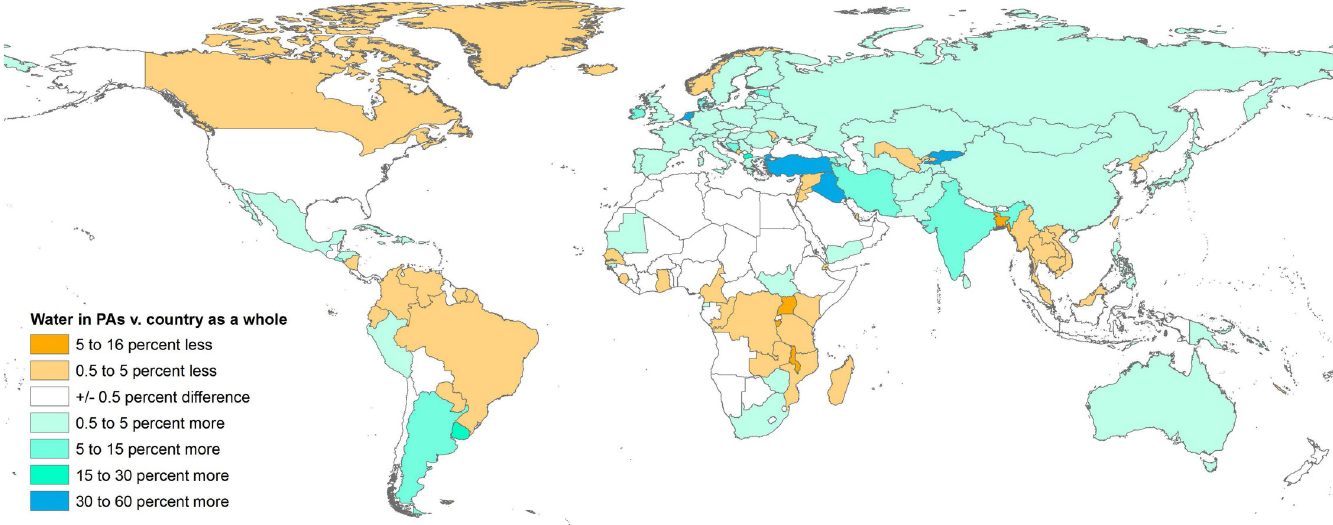
Fig 2. Representativity of water protection, by country. Difference between the percentage of a country’s area covered by surface waters in 2015 and the percentage area of that country’s PAs which is covered by surface waters. Positive values (bluish colours) indicate that surface waters are represented in PAs more often than would be expected by chance (i.e. that the PA system preferentially covers surface water